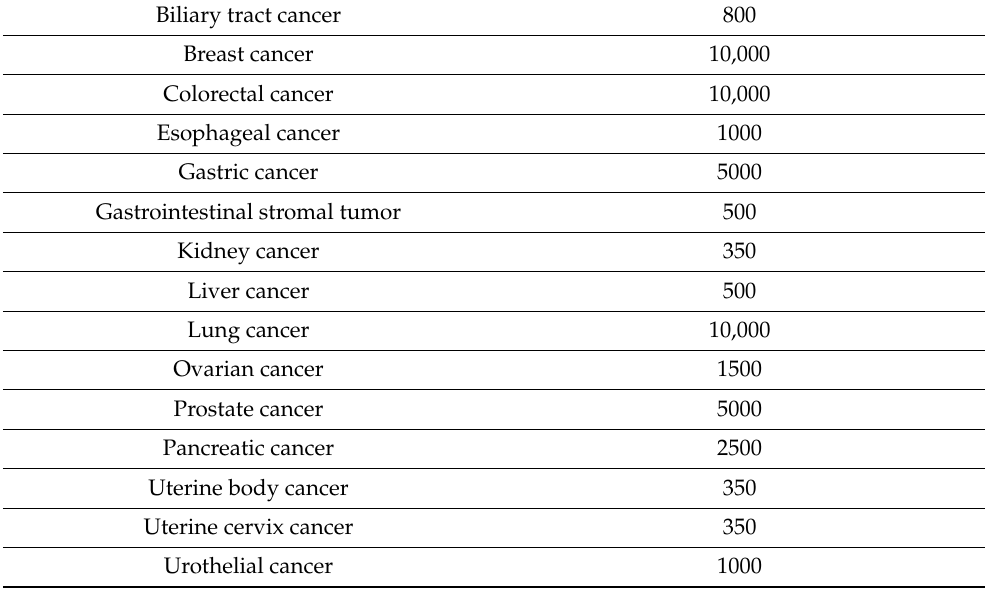
Table 3. Sample size of each cancer